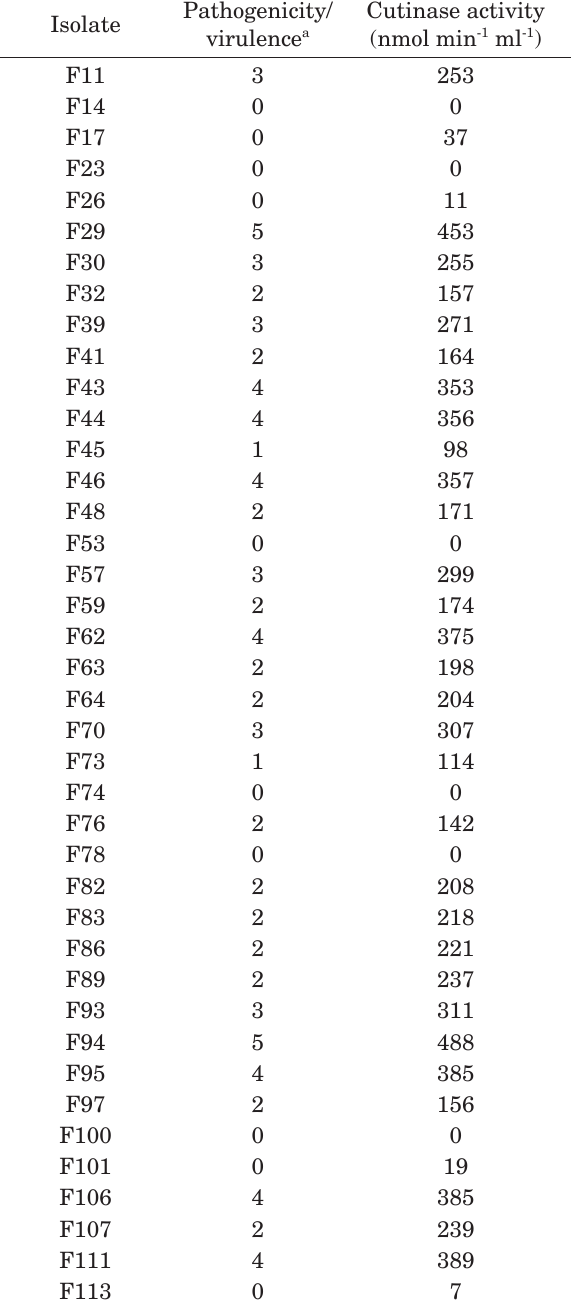
Table 2. Cutinase activity of Fusarium solani isolates grown in liquid cutin medium and their pathogenicity/ virulence on potato